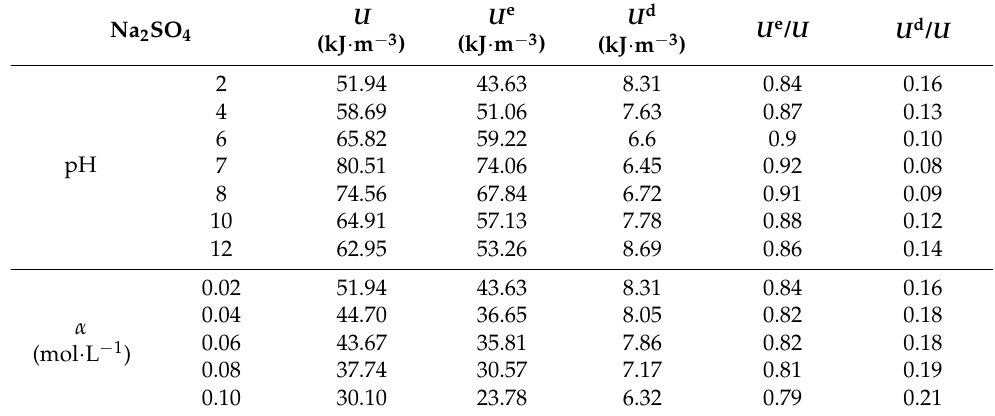
Table 4. Characteristic stress of Na 2 SO 4 corroded sandstone ( σ 3 = 10